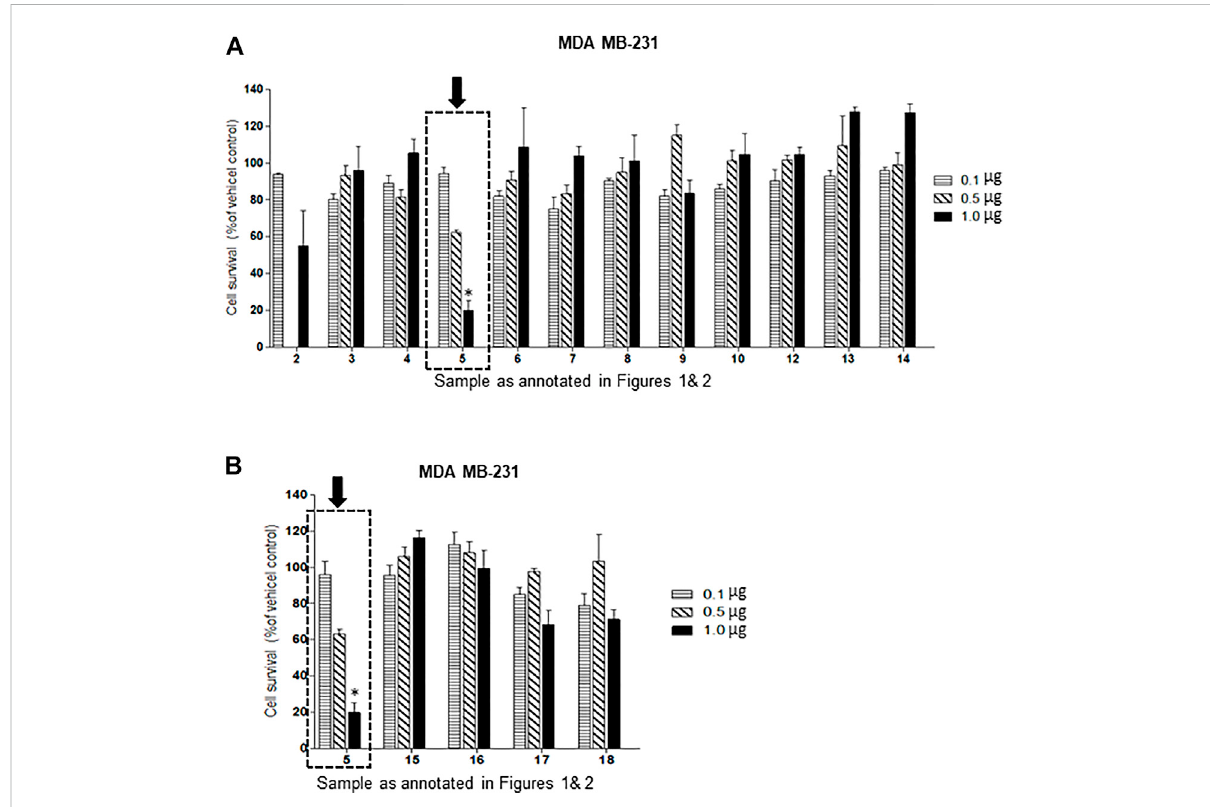
FIGURE 4 (A,B) : Dose-response comparison of the cytotoxic effects of various sterols (as % of ethanol vehicle control) shown to be present in EGS in this study on MDA MB-231 an estrogen receptor negative breast cell line in vitro . The cell survival data presented as percentage of vehicle control determine the signi fi cant potency of only triol #5 in the tested cell line ( n = 3, p < 0.05, One-way ANOVA with Dunnett ’ s post-test to compare response of different